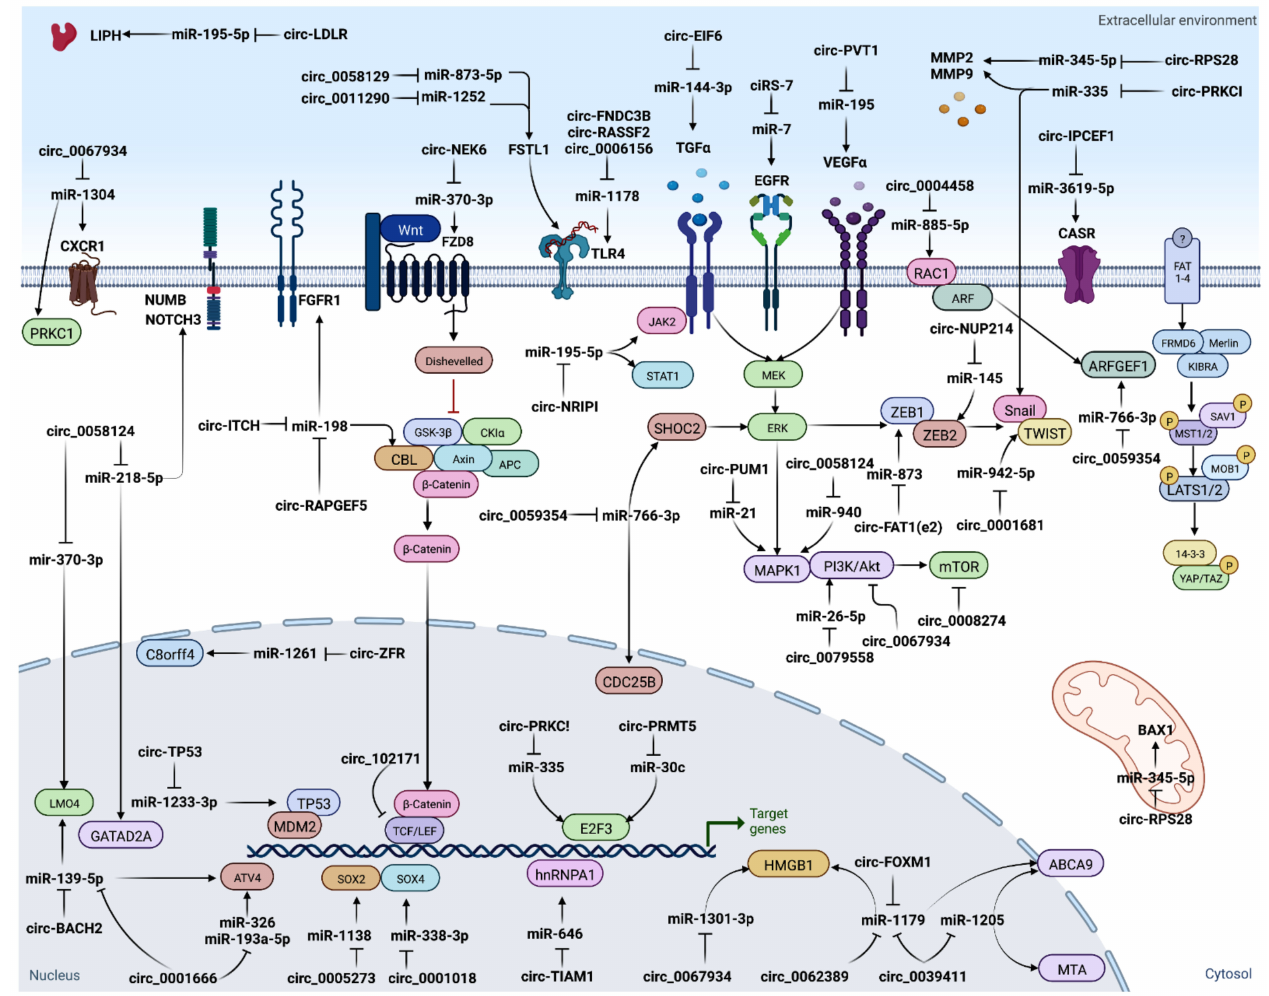
Figure 3. CircRNAs serve as miRNA